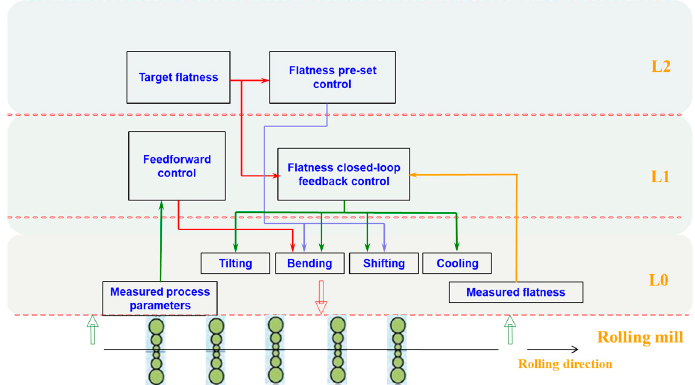
Figure 2. Flatness control system.